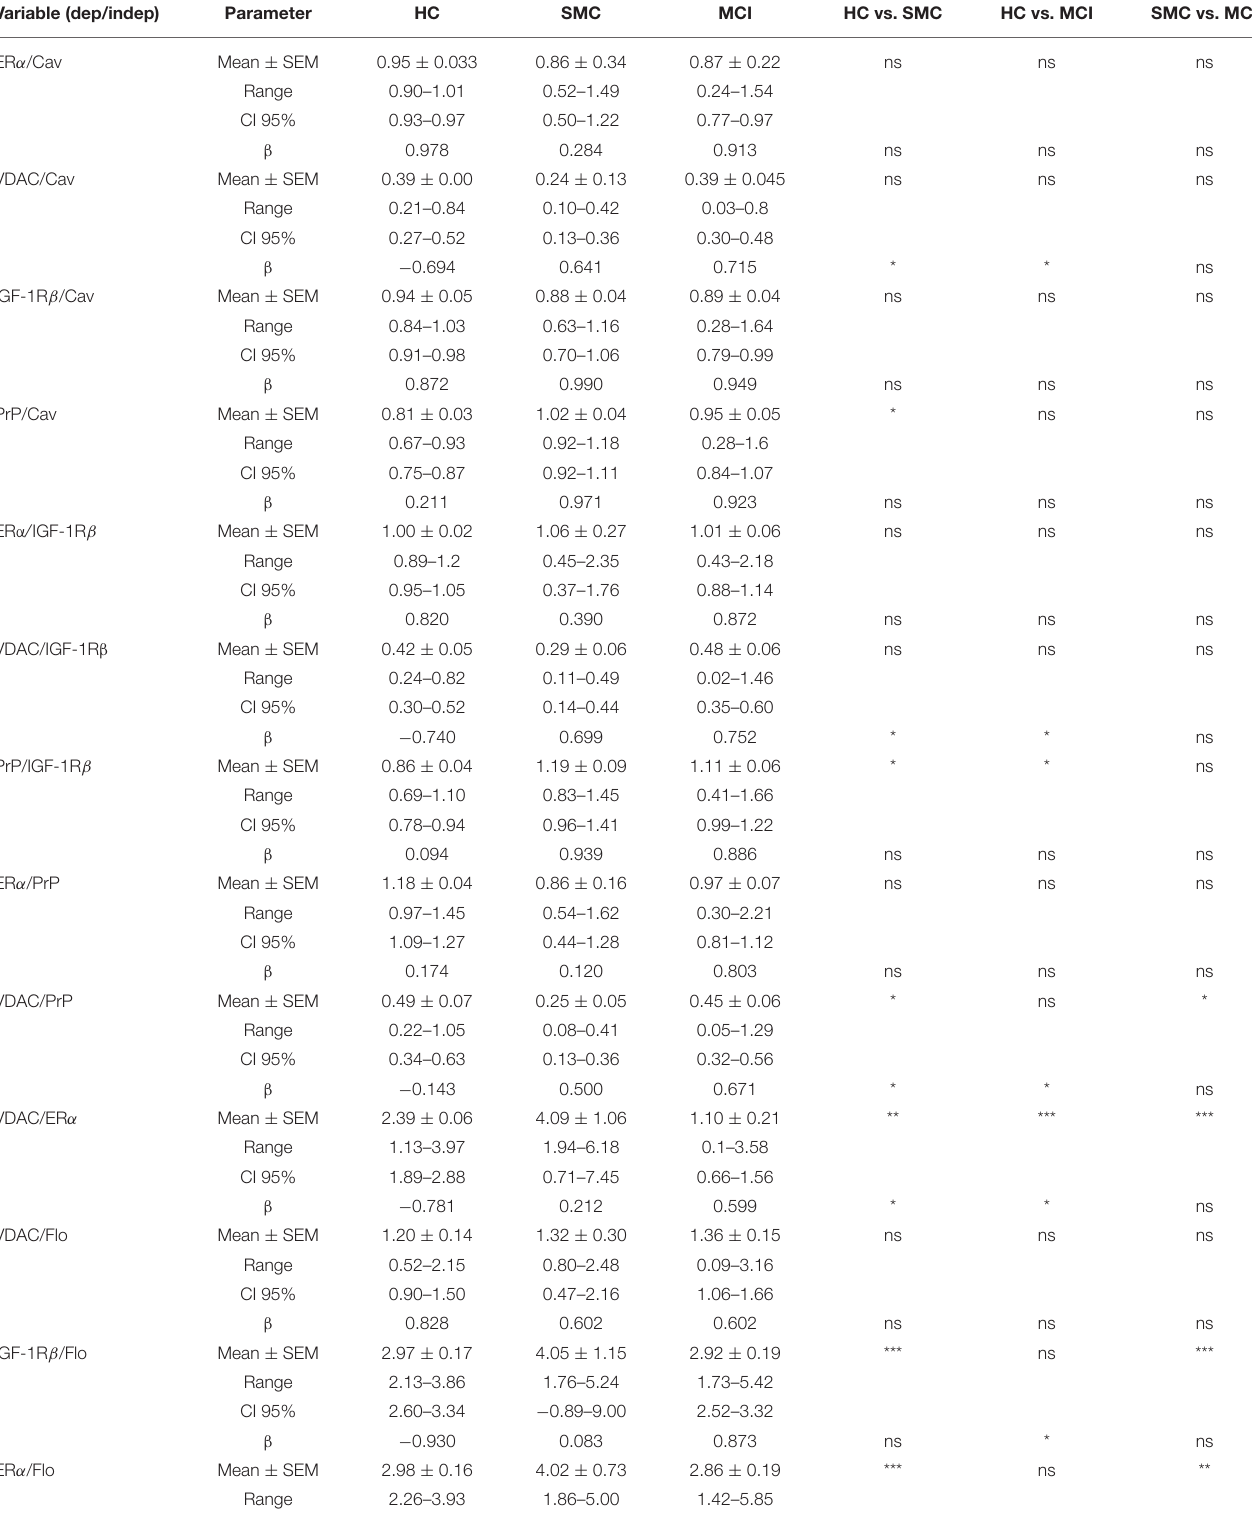
TABLE 2 | Comparative analyses of bivariate relationships between ER-signalosome proteins. Variable